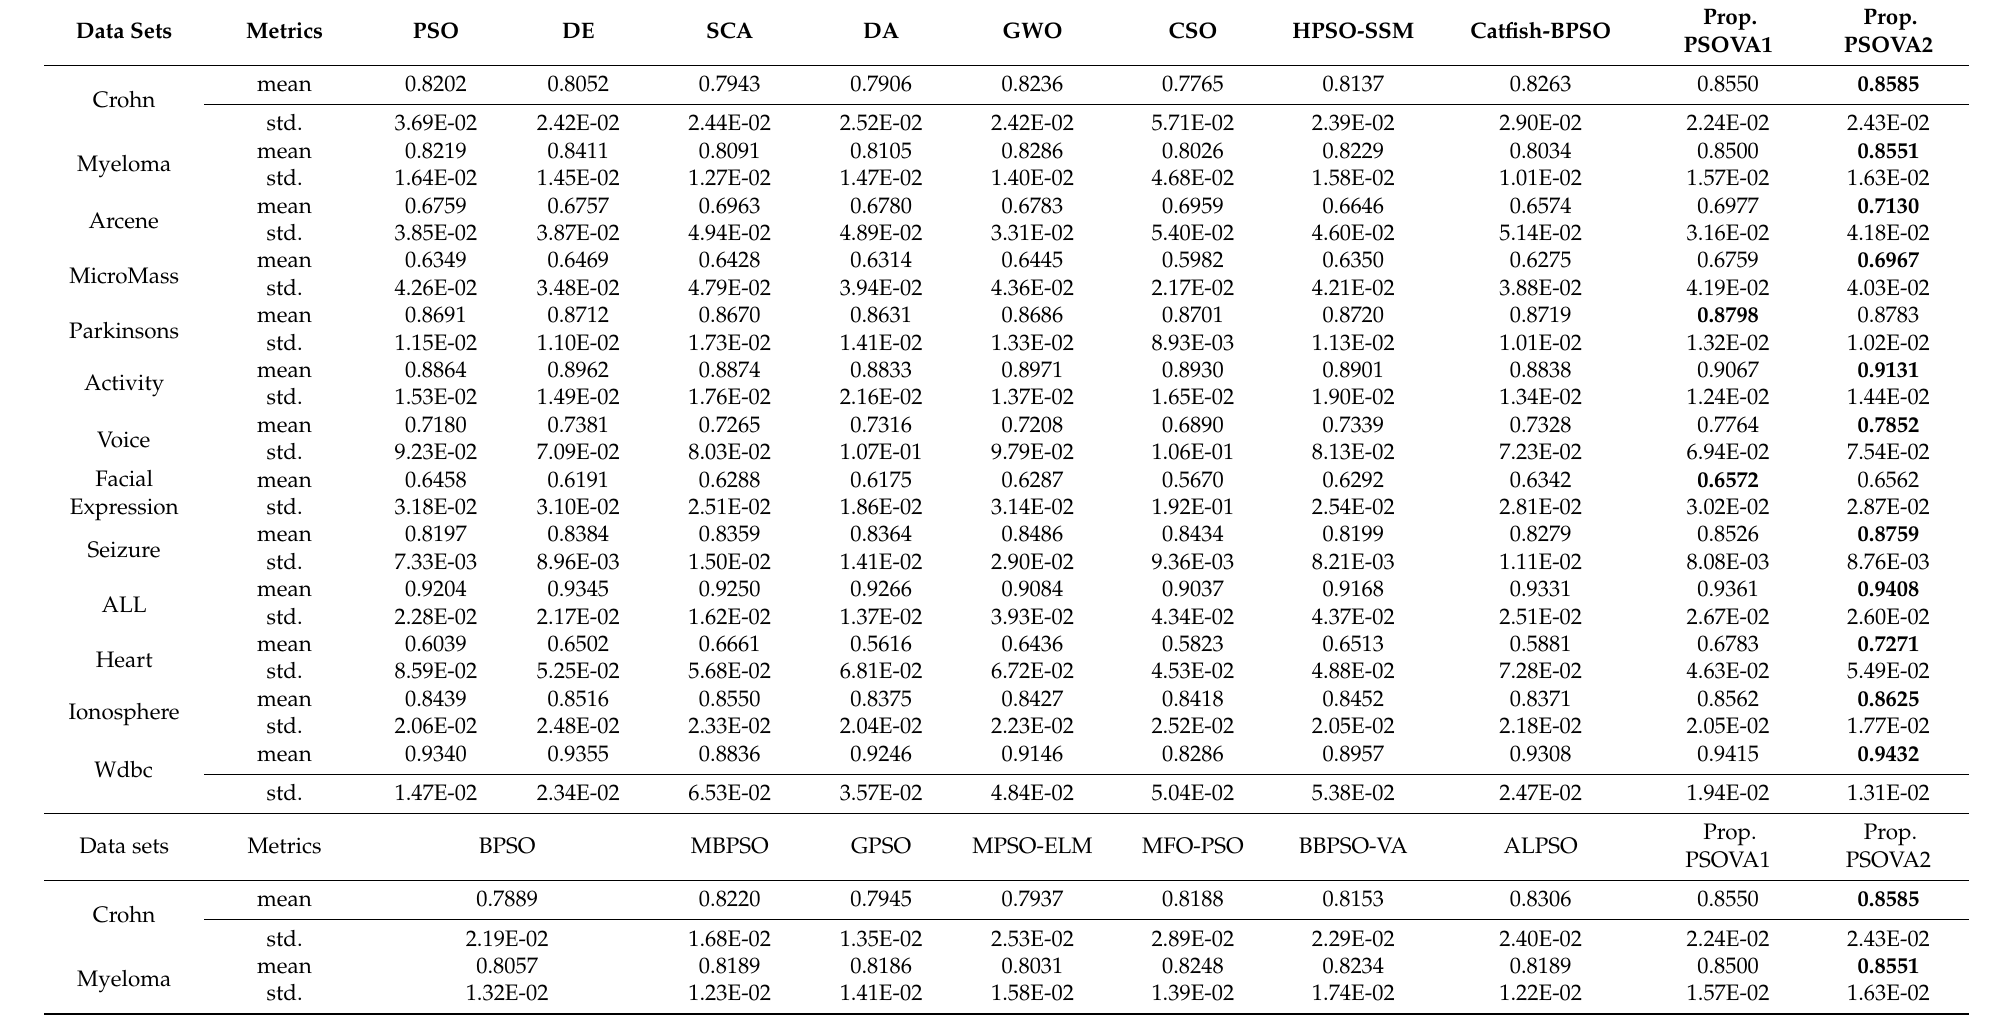
Table 5. The mean results of the F-score measures over 30